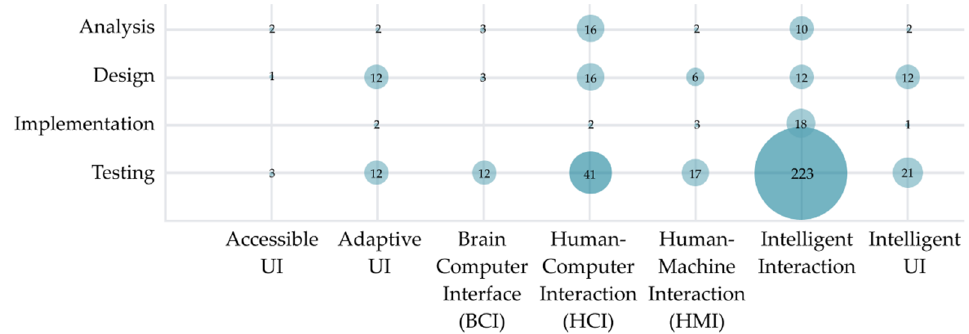
Figure 12. Distribution of HCII solutions’ development phases according to the research standpoint.